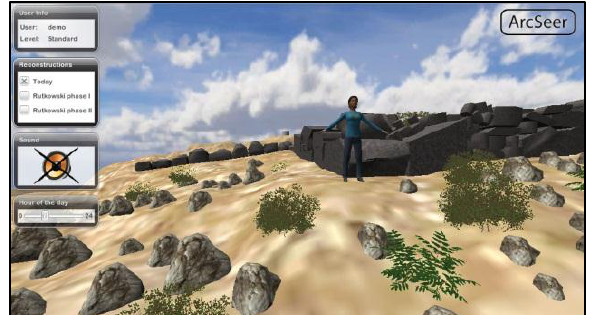
Figure 5: The ArcSeer